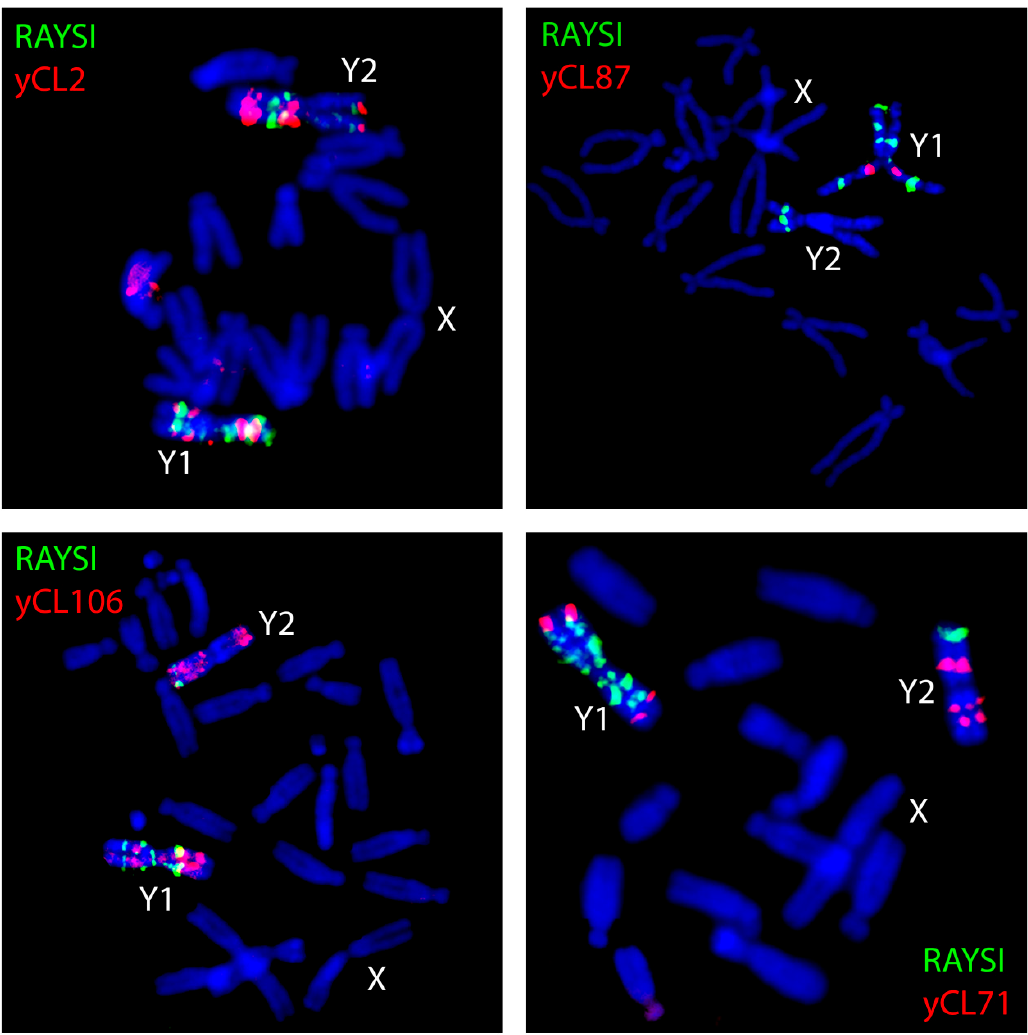
Figure 2. Localization of satellites on metaphase chromosomes of Rumex acetosa using FISH. The name of the satellite or number of satellite cluster is inside each figure.